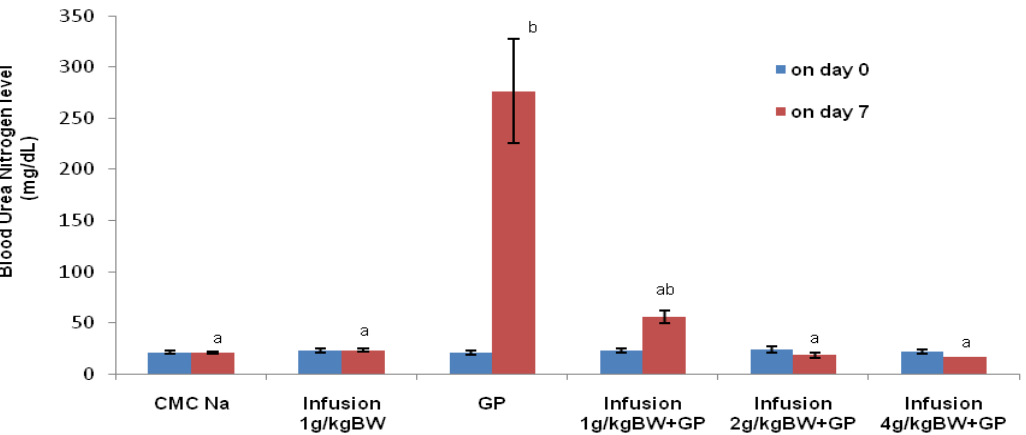
a significant at p<0.05 with nephrotoxic control Gentamicin-Piroxicam (GP) b significant at p<0.05 with normal control (CMC Na) Figure 2. Level of BUN (mean±SD) on day 0 and after treatment of sarang semut infusion for 7 days in induced by gentamicin-piroxicam rats (GP)